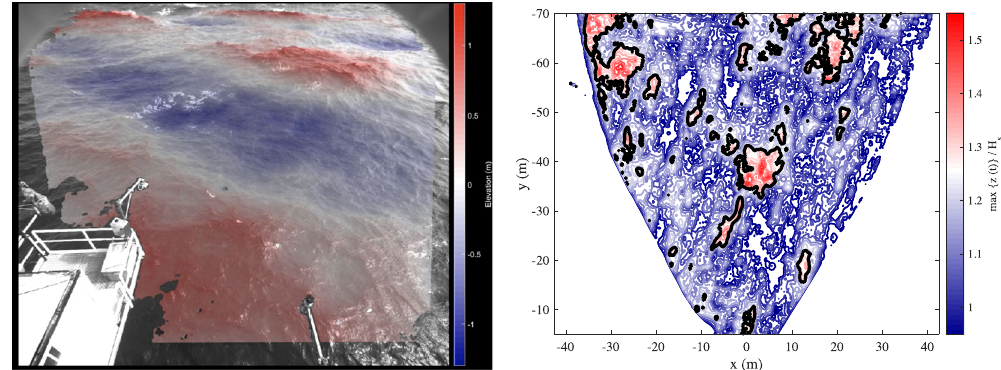
Figure 3. (left panel) Example of 3D wave field (shown in the camera reference system) measured with a stereo wave imaging system installed on the Acqua Alta platform (northern Adriatic Sea, Italy). (right panel) The contour lines show the normalized maximum sea surface elevation max{ z ( t ) | t ∈ D }/ H s at each position P ∈ Ω during the time interval D . The thick black contour corresponds to the rogue wave threshold 1.25 H s